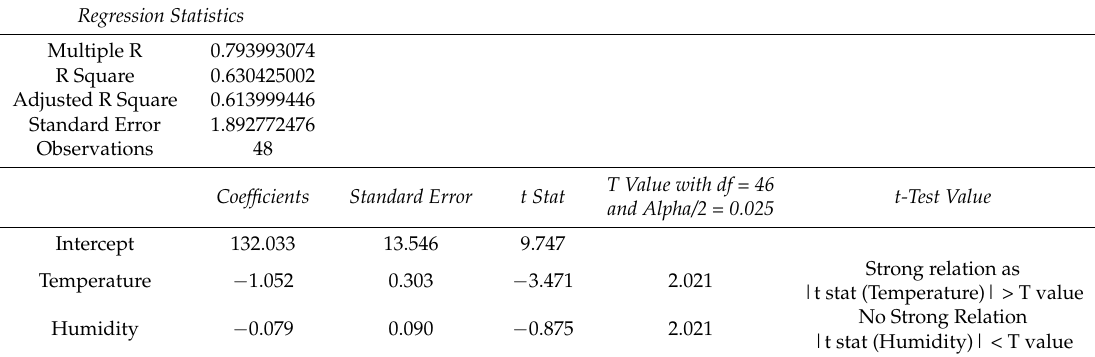
Table 2. Regression analysis output and t-test approach on the data for month of